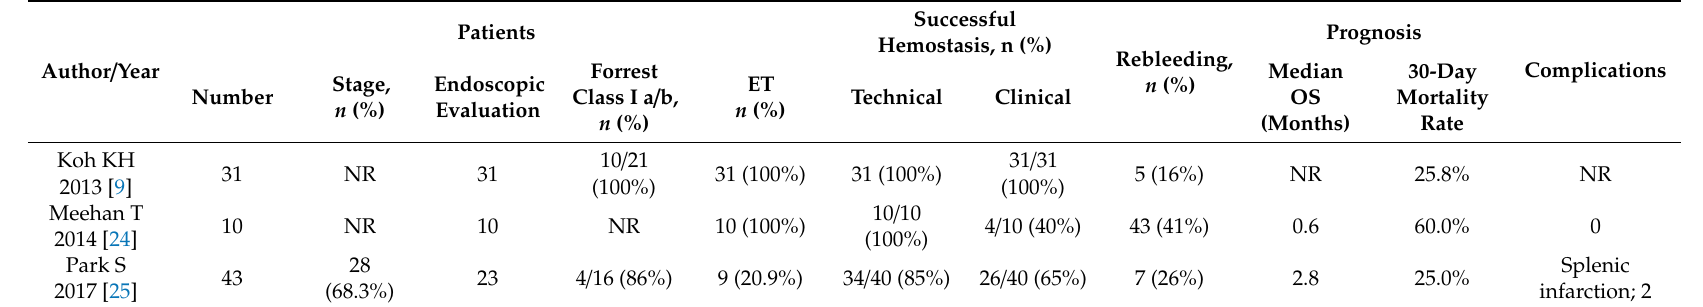
Table 2. Characteristics and results of transcatheter angiographic embolization for bleeding from gastric